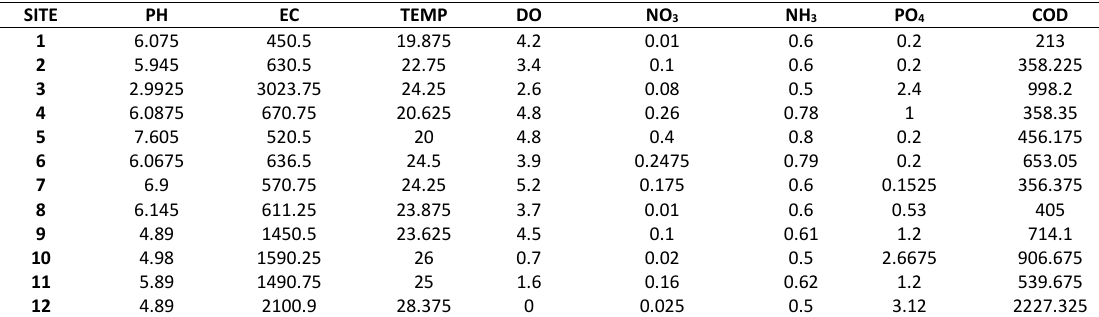
Table 1: Averages of physicochemical water variables at sites on the Mukuvisi River during the dry season SITE PH